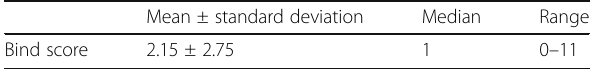
Table 6 Results of BIND-M score in studied neonates in group (2) Mean ± standard deviation